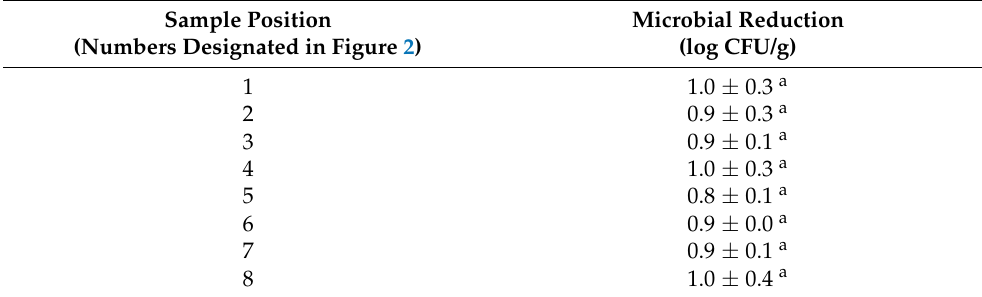
Table 1. Microbial inactivation efficiency of in-package cold plasma (CP) treatment against indigenous aerobic mesophilic bacteria at different positions in the